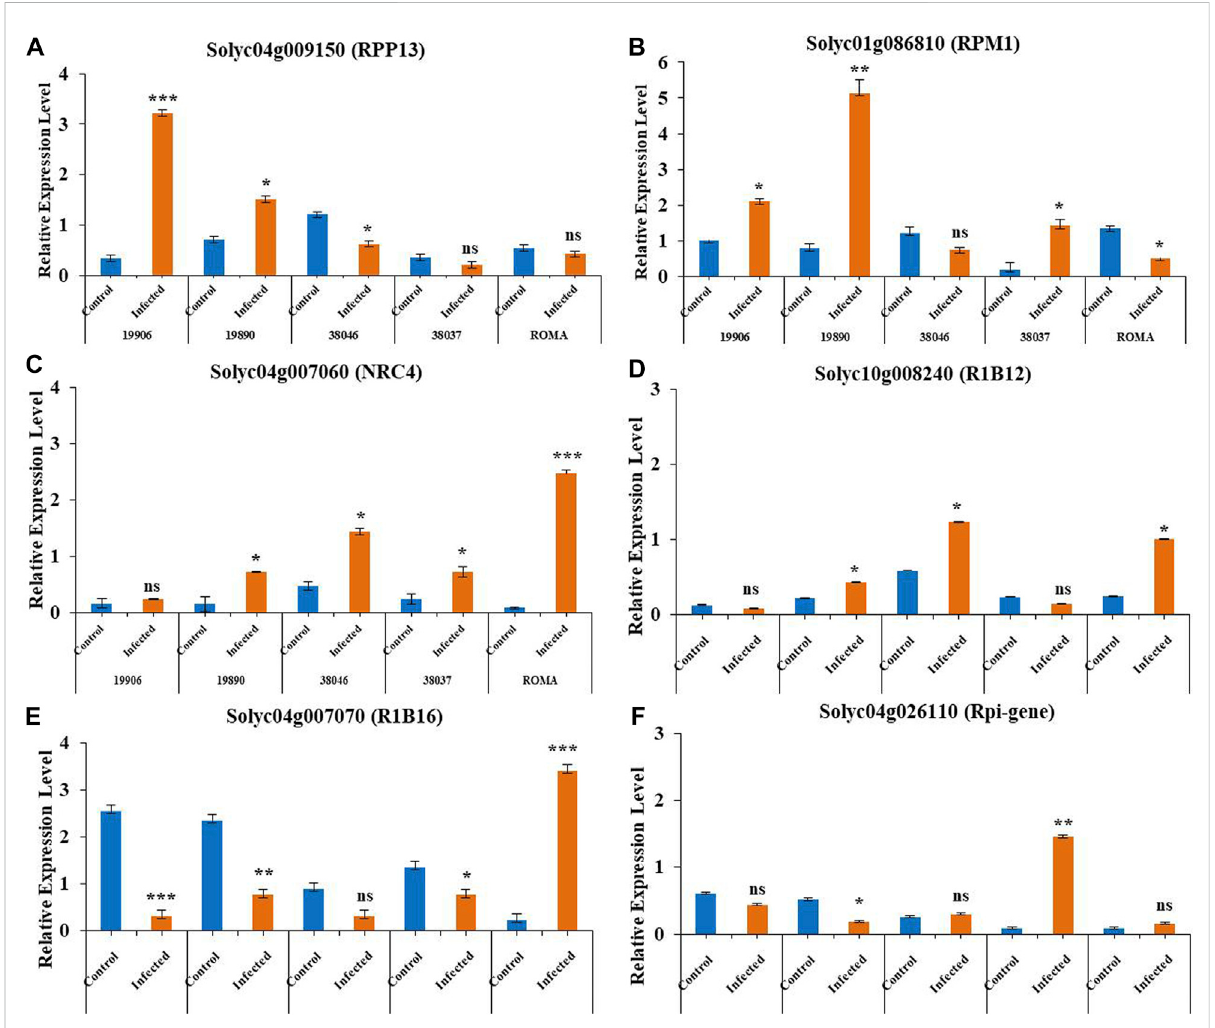
FIGURE 7 Relative expression levels of six NLR genes in tomato in response to fungal (early and late blight) disease condition. Three technical replicates were performed, with EF (elongation factor) as the positive control (reference gene). Light orange: infected; blue: control. *P ˂ 0.05, **P ˂ 0.01,